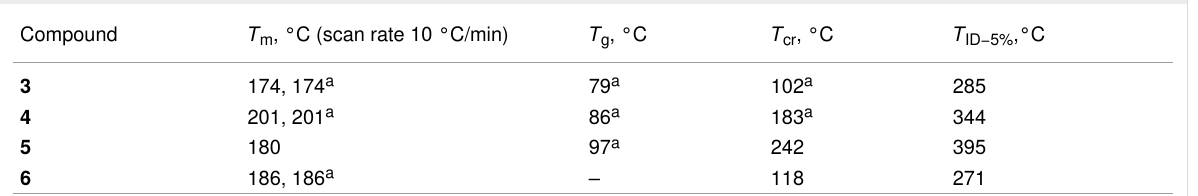
Table 1: Thermal characteristics of acridan-based compounds 3–6 .